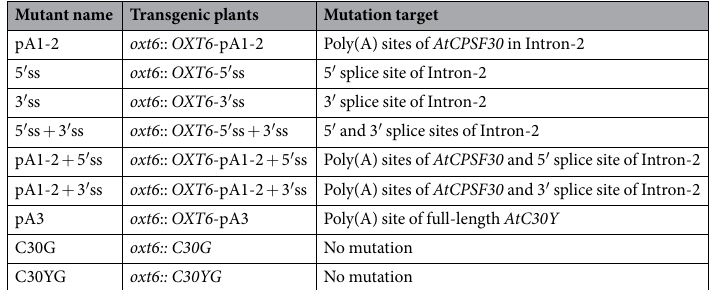
Table 1. OXT6 mutation constructs and transgenic plants used.